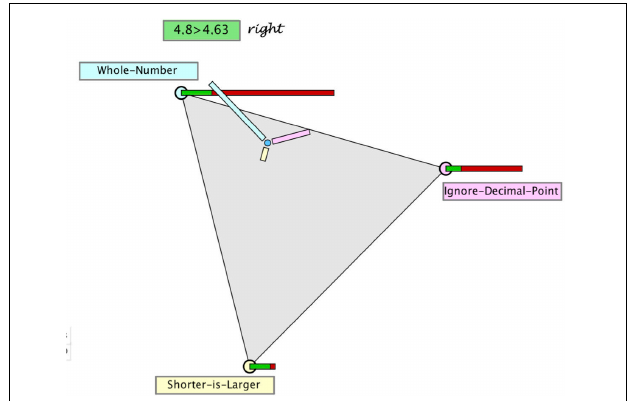
FIGURE 5 | Hypothegon with visual explication of the interaction of priors and